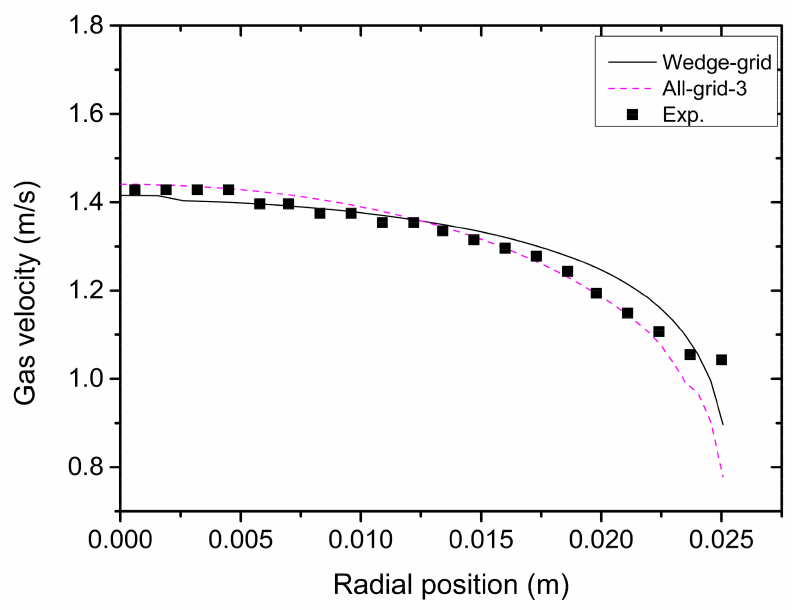
Figure 6. Simulation results by All-grid-3 and